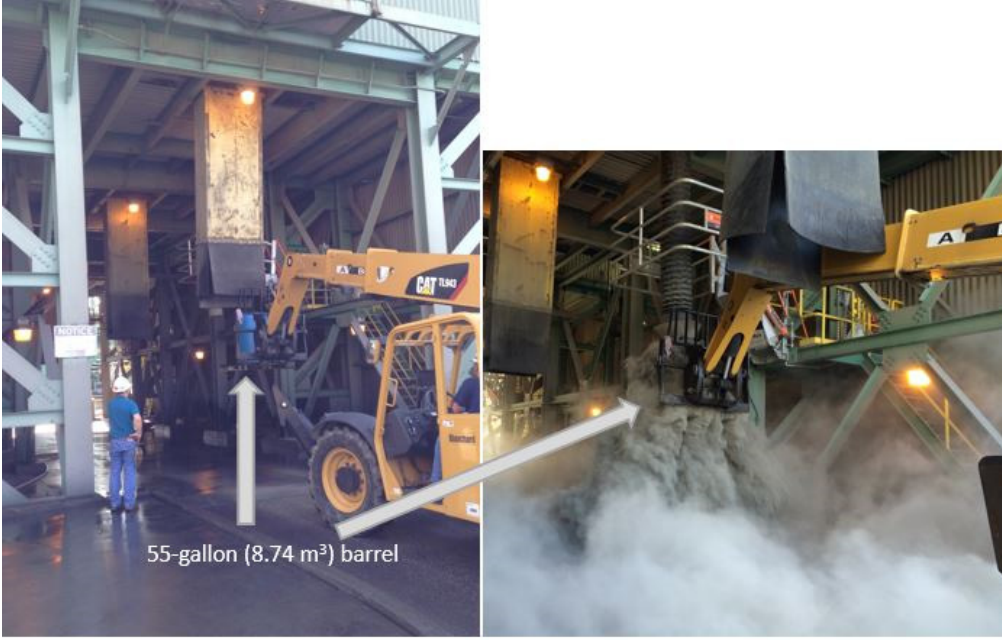
Figure 1. Filling of barrel with fly ash.